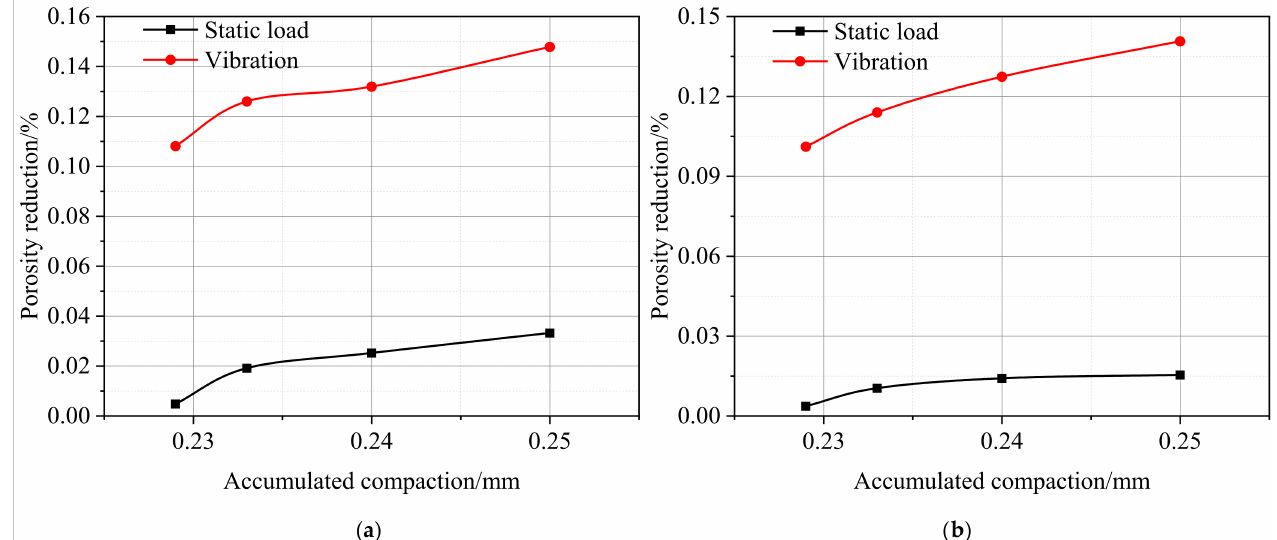
Figure 10. Porosity changes at different locations; ( a ) Upper position porosity changes (x-axis shows the compaction amount, y-axis shows the porosity reduction); ( b ) Middle porosity changes (x-axis shows the compaction amount, y-axis shows the porosity